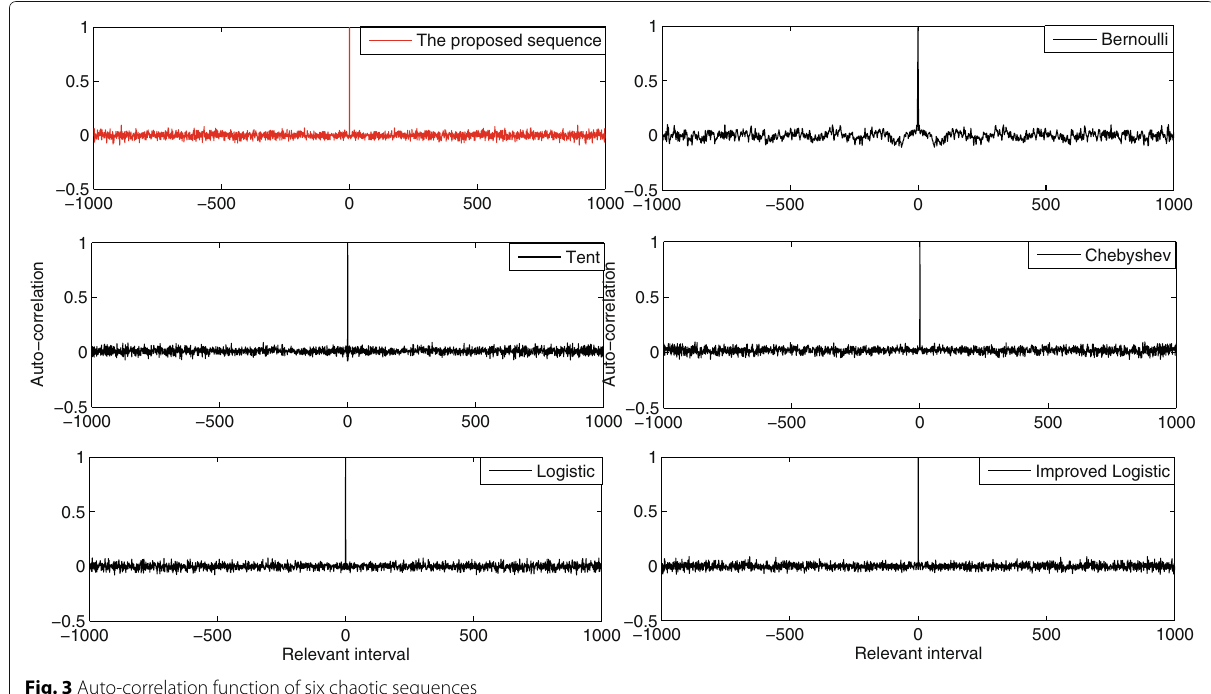
Fig. 3 Auto-correlation function of six chaotic sequences